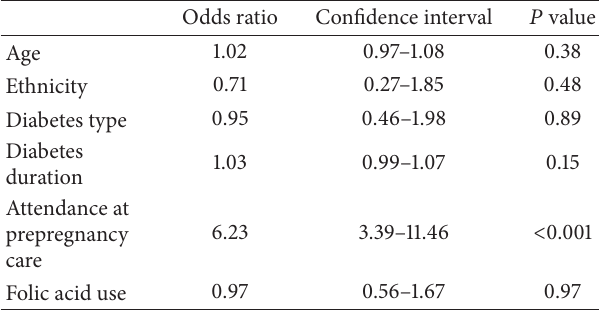
Table 3: Maternal factors associated with receiving appropriate retinal evaluation during